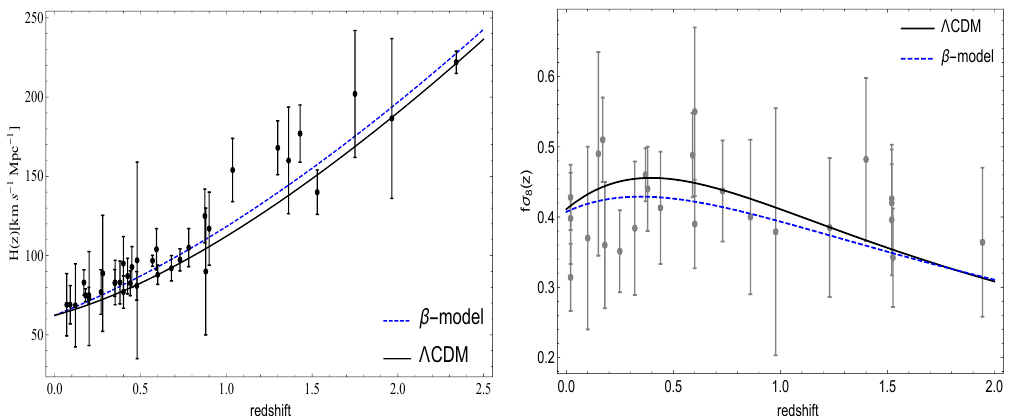
Figure 3. In the left panel, the Hubble function is presented with its evolution in terms of redshift. In the right panel, curves of the f σ 8 evolution show a comparison with the Λ CDM model (black thick dashed). (For interpretation of the references to color in this figure legend, the reader is referred to the web version of this article).